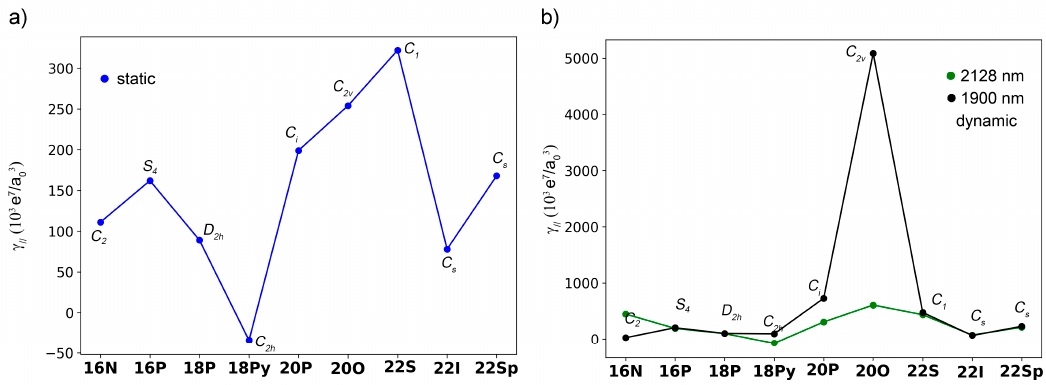
Figure 14. Evolution of the longitudinal component of the second hyperpolarizability ( γ // ) in static ( a ) and dynamic regime (1900 nm and 2128 nm) ( b ). The symmetry point group for each system is also shown.